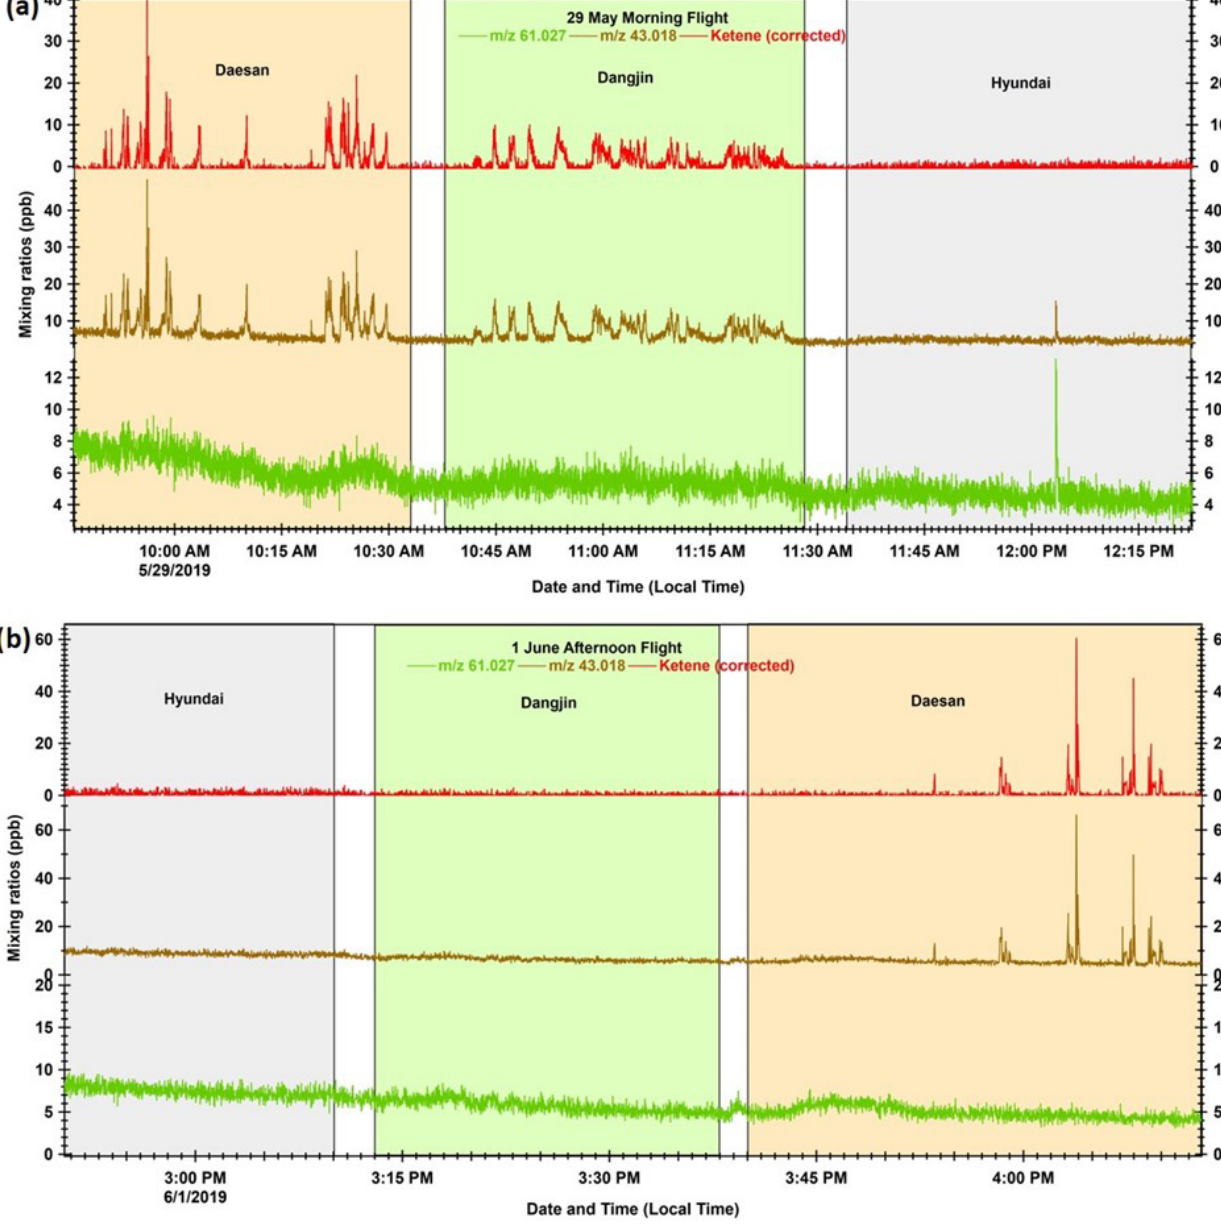
Figure 2. Time series profiles for mixing ratios (1Hz resolution) of acetic acid and glycolaldehyde parent ion ( m/z = 61.027), ketene fragment ( m/z = 43.018), and corrected ketene (corrected for m/z 61.027 fragmentation) during the (a) 29 May morning flight and (b) 1 June afternoon flight. The light pink, light green, and light blue shaded areas represent the duration of the flights over Daesan, Dangjin, and Hyundai,